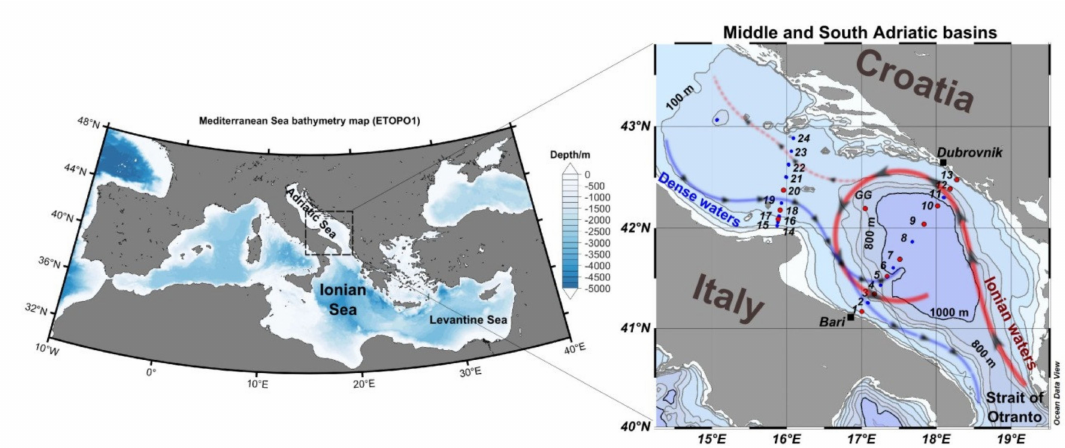
Figure 1. Bathymetric map of the Mediterranean Sea with a zoom (right panel) of the study area in the Adriatic Sea. Conductivity-temperature-depth (CTD) stations (blue dots) of the Evolution and Spreading of the Southern Adriatic Waters (ESAW) cruises in December 2015 (10th–15th) and in April 2016 (5th–10th). Superimposed red dots indicate zooplankton sampling stations. Stations 14–24 form the Middle Adriatic Transect, and stations 1 to 14 form the South Adriatic Transect. Blue and red lines show a schematic of the south Adriatic winter